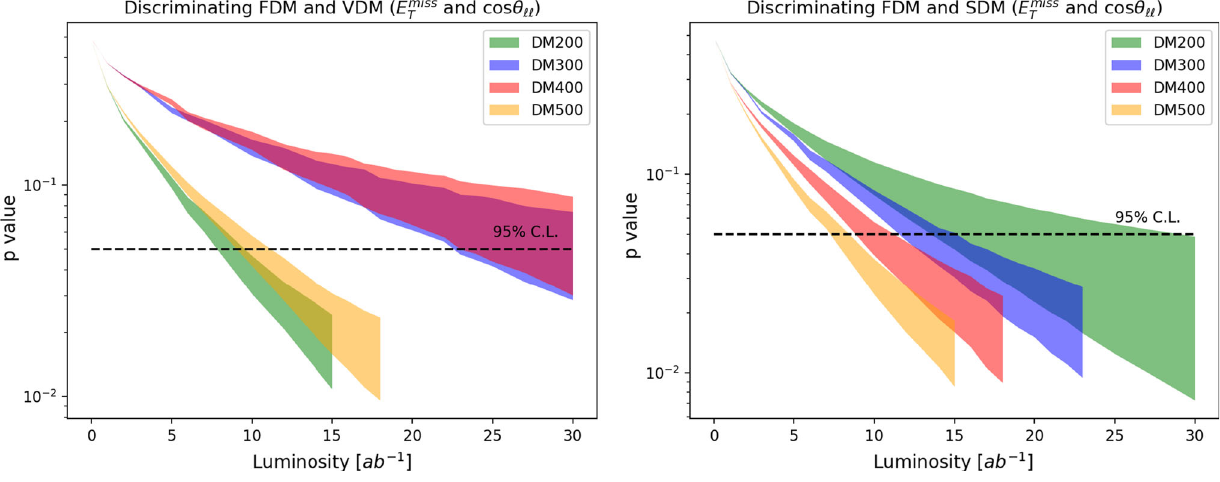
Fig. 9 Spin discrimination prospects between FDM and VDM in the plotted in the same way as explained in the caption of Fig. 6, but here left panel; between FDM and SDM in the right panel. The two dimen- the systematic uncertainty is assumed to be slightly smaller, i.e. sion distributions in the cos (θ (cid:11)(cid:11) ) and E miss plane are used. Bands are T